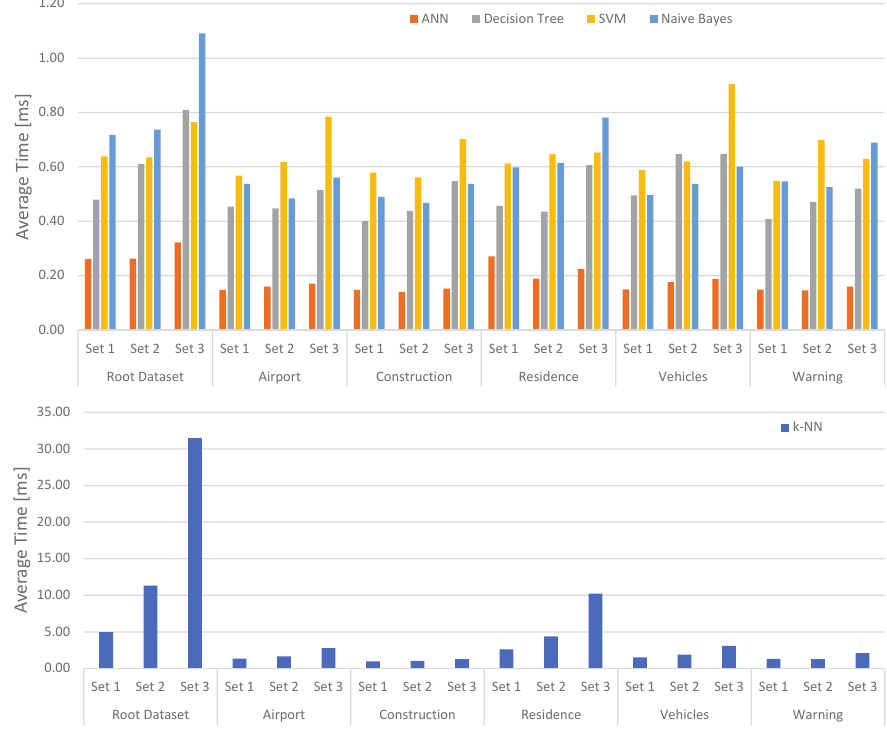
Figure 10. Average timing of the classifiers running with their default